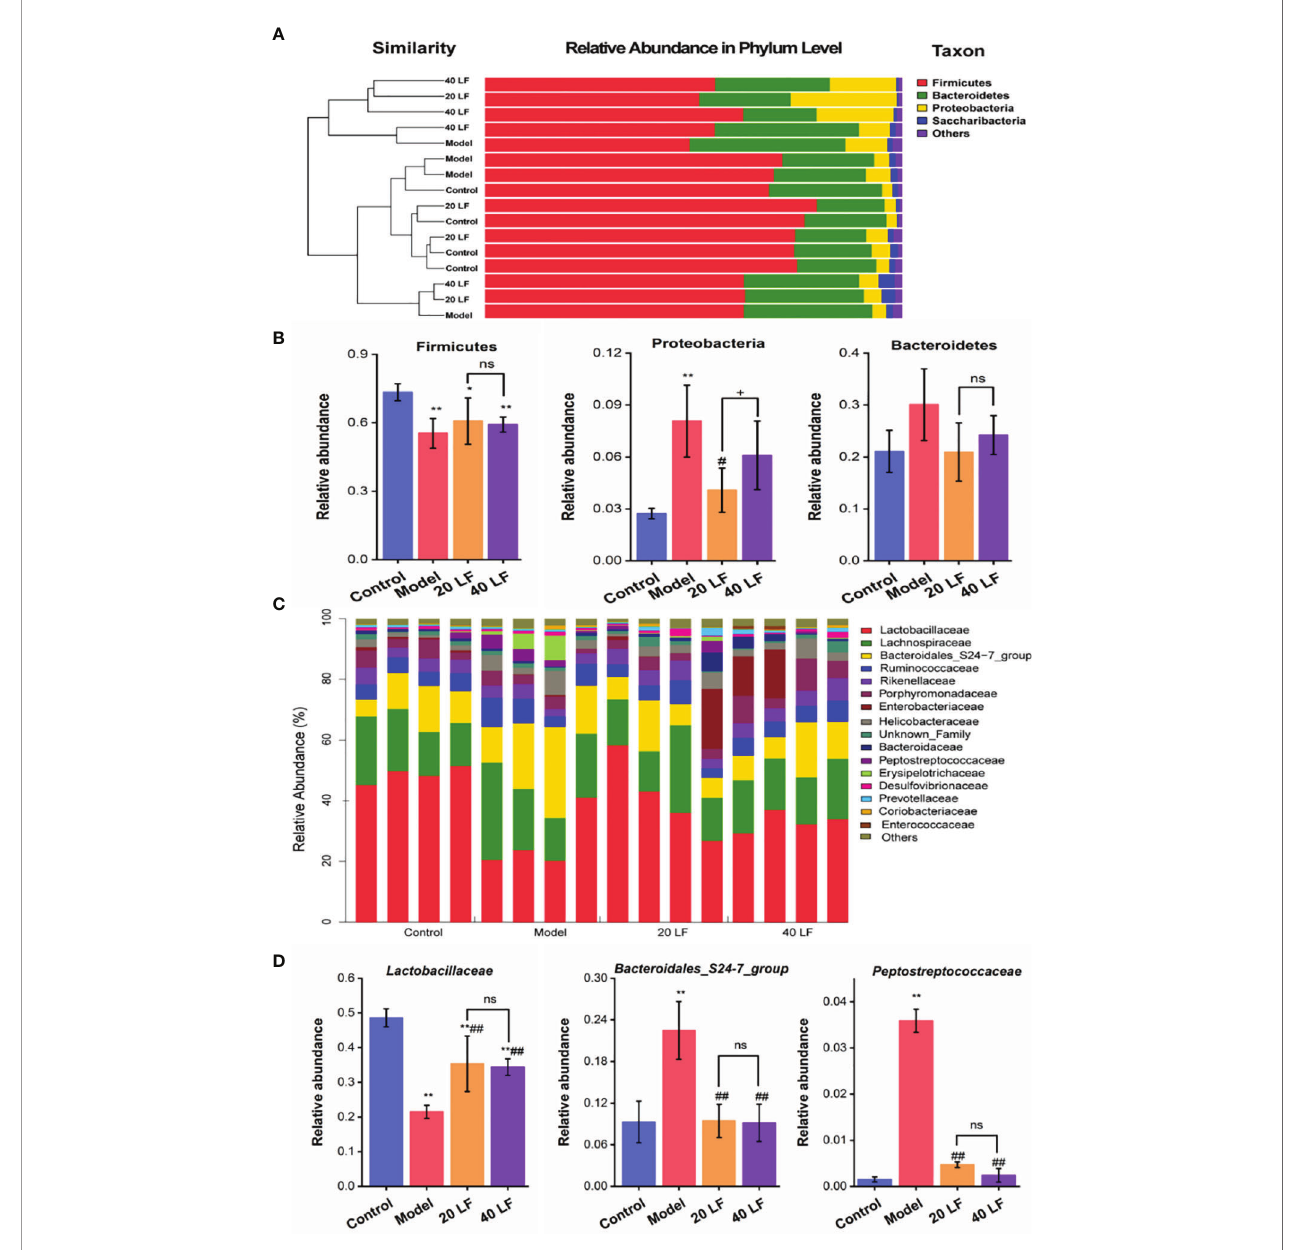
FIGURE 6 | Comparisons of the gut microbiota at phylum and family taxonomic levels ( n = 4). (A) Gut microbiota composition at the phylum level. (B) Relative abundance of the gut microbiota at the phylum level. (C) Gut microbiota composition at the family level. (D) Relative abundance of the gut microbiota at the family level. * P < 0.05, ** P < 0.01 vs control; # P < 0.05, ## P < 0.01 model, + P < 0.05 compared between 20 LF and 40 LF, and ns means no signi fi cant